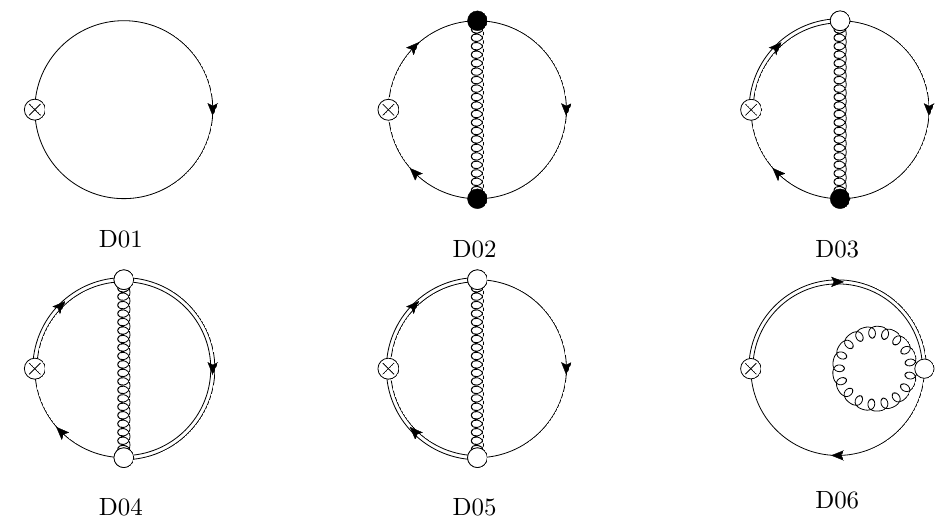
( t; x ) i at leading order (D01) (cid:22)